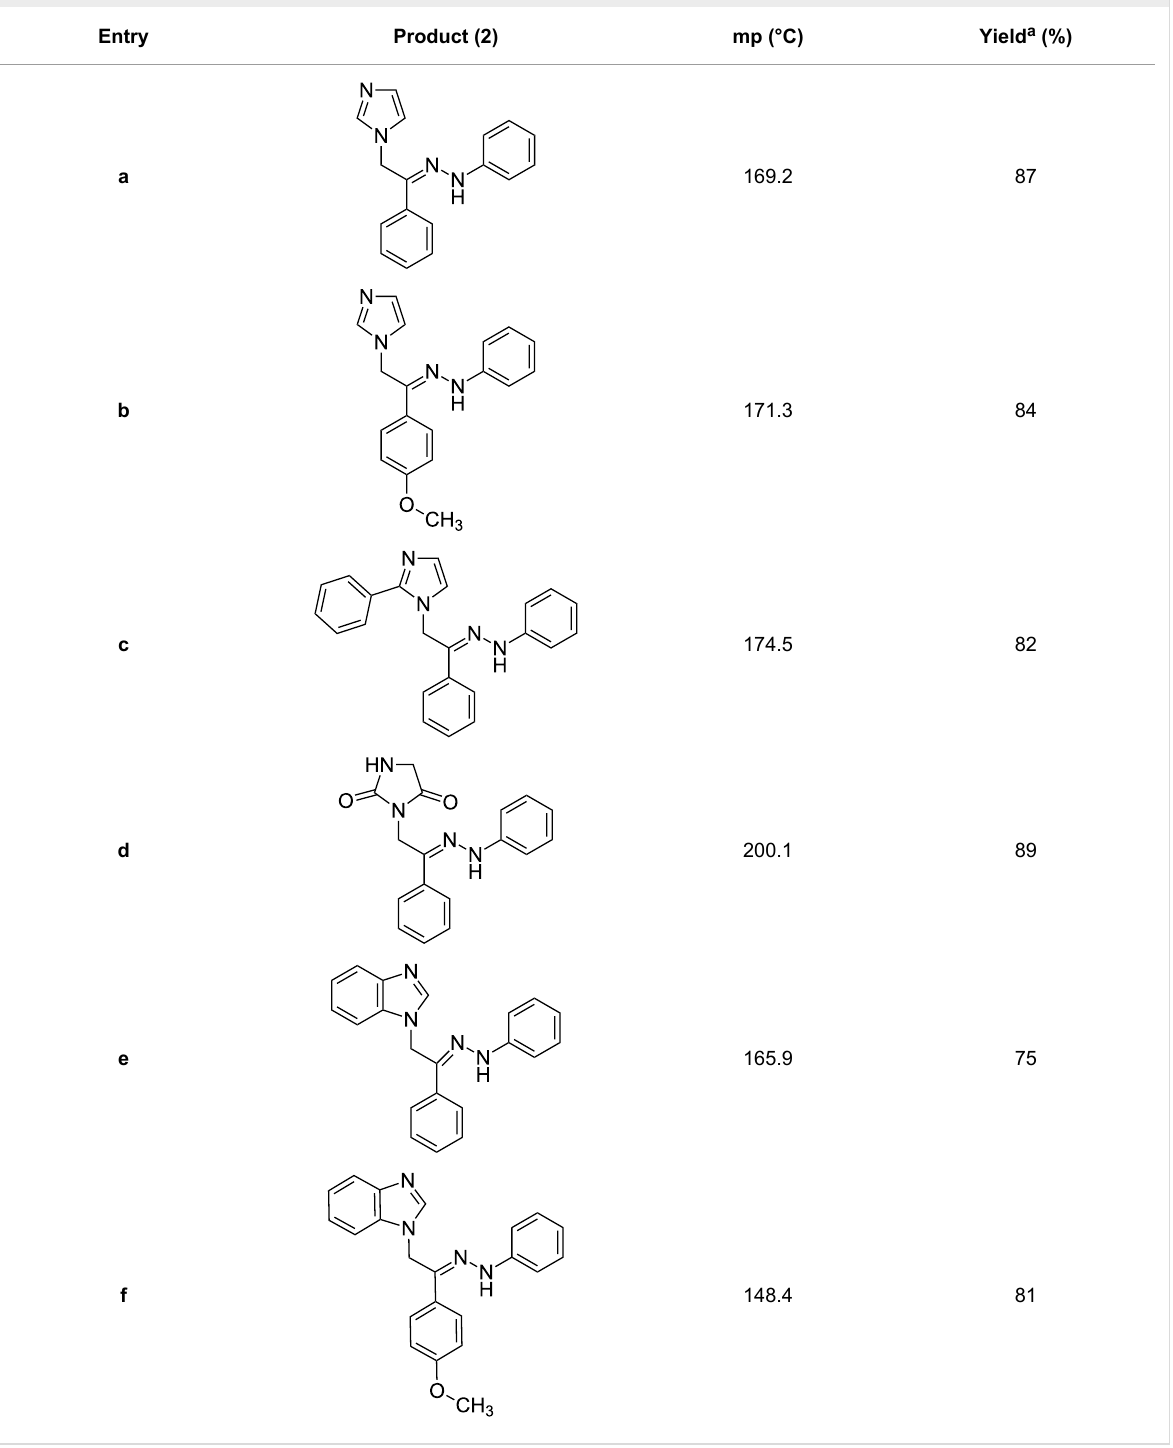
Table 1: Synthesized hydrazono acyclic nucleoside